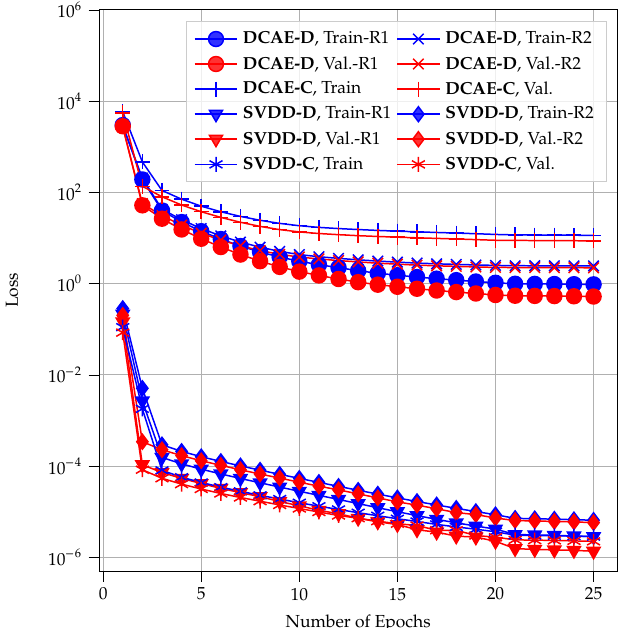
Figure 11. Learning curves of the DCAE used in DCAE-D , DCAE-DP , DCAE-C , and DCAE-CP and the Deep SVDD used in SVDD-D and SVDD-C . The learning curves for the training dataset (denoted as Train), the validation dataset (denoted as Val.), and two receivers, in the case of decentralized approaches (denoted as R1 and R2), are